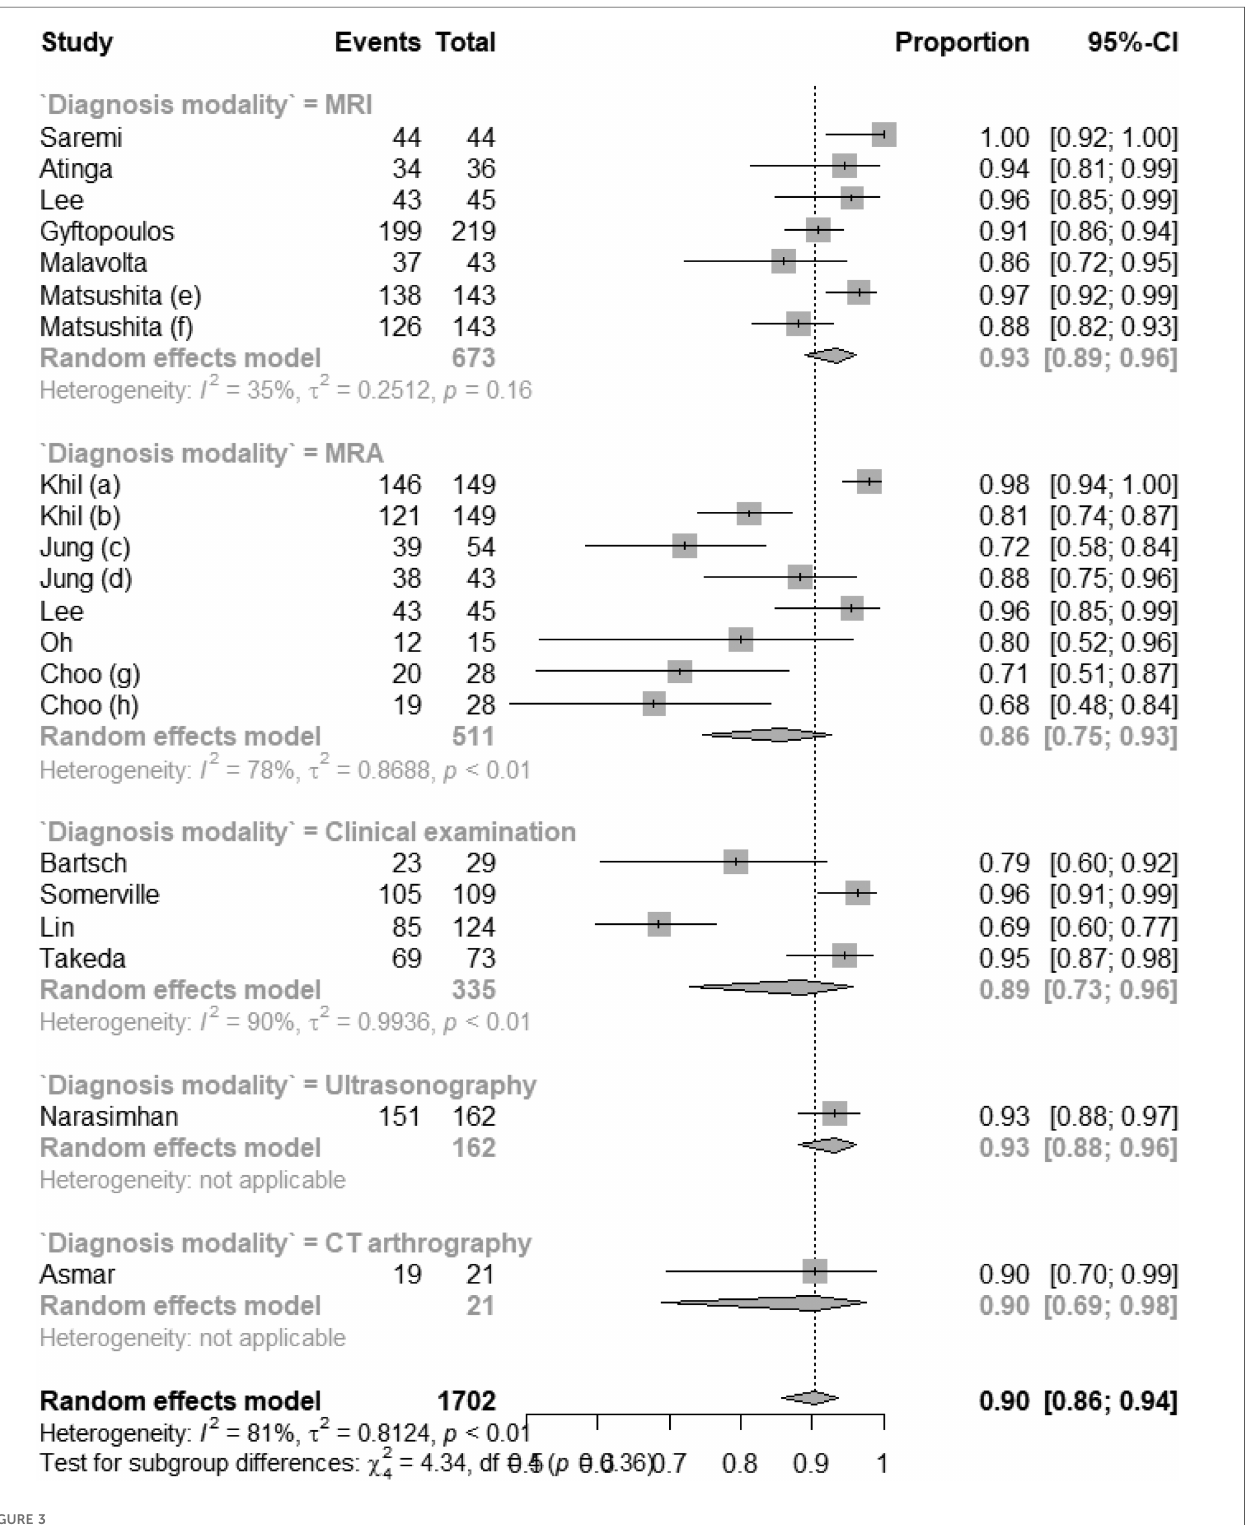
FIGURE 3 Forest plot of speci fi city of different diagnostic